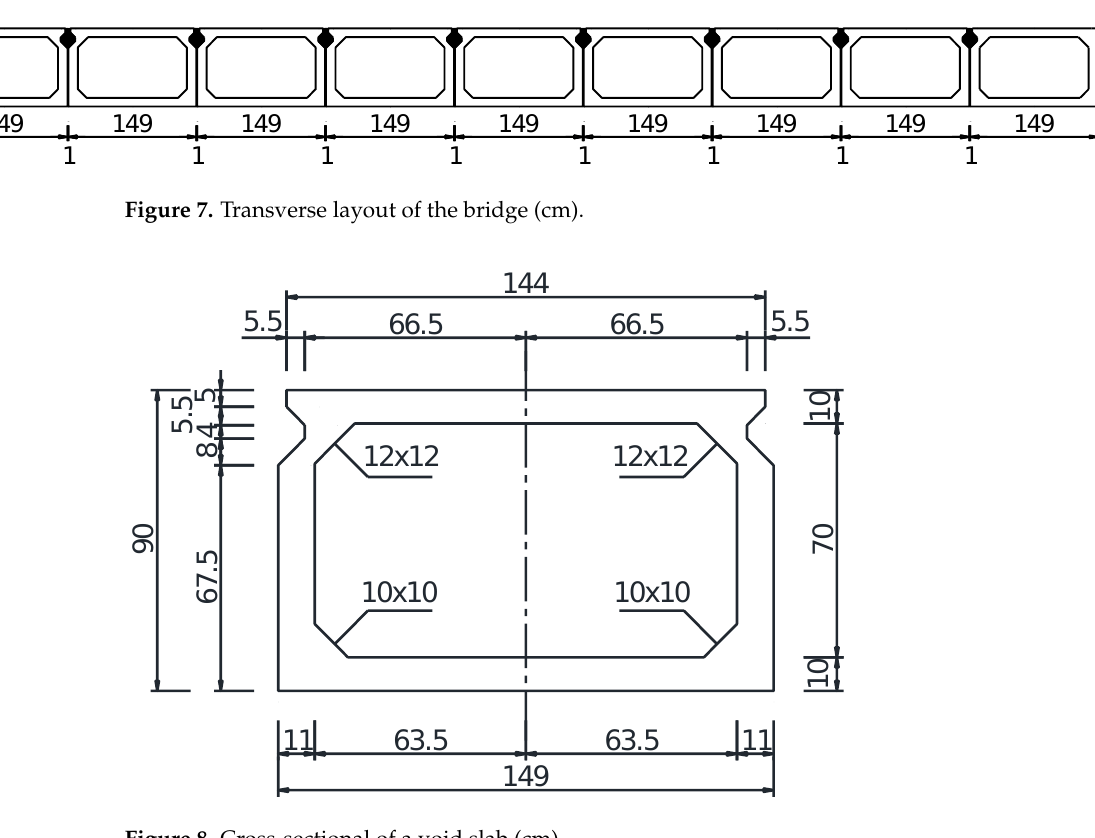
Figure 8. Cross-sectional of a void slab (cm).